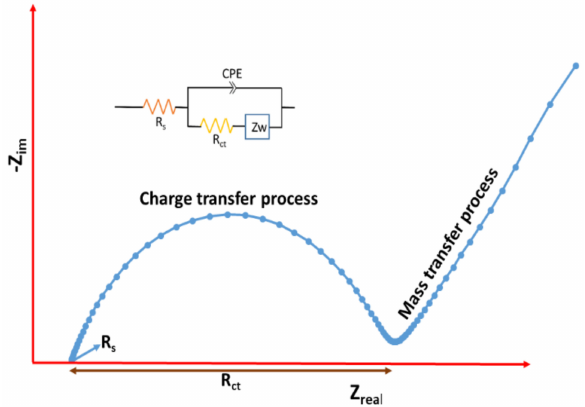
Figure 16. Randles circuit and corresponding Nyquist